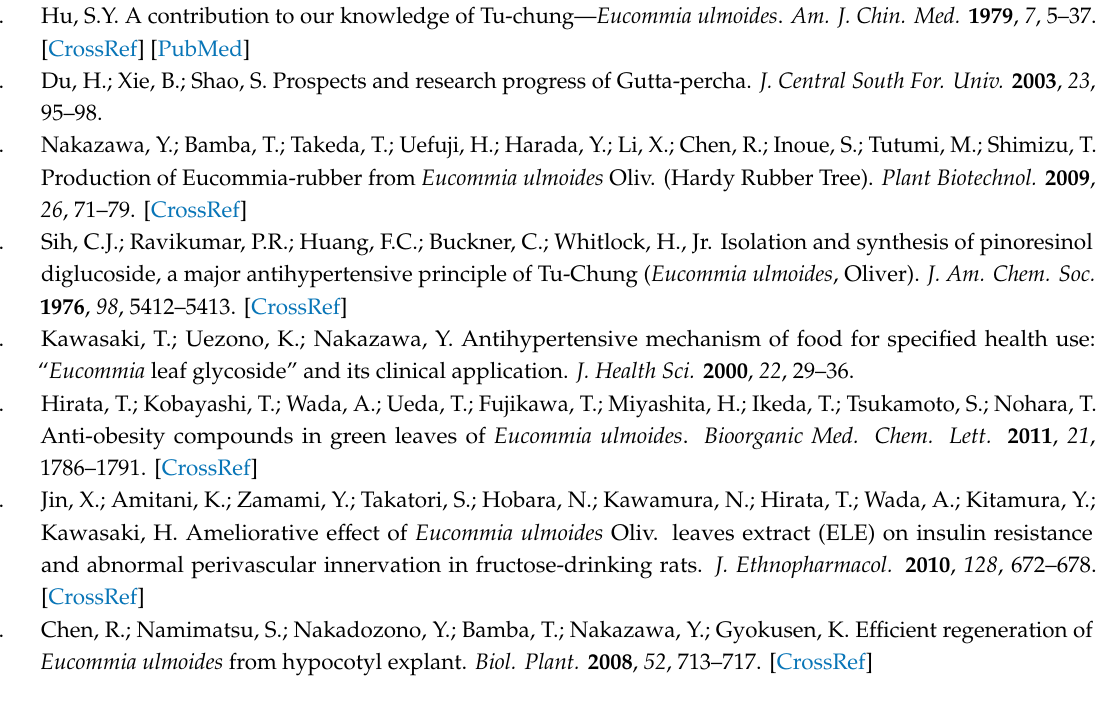
Table S1: Primer sequence of SSR markers, Table S2: Segregation of SSR locus, Table S3: The correlation coe ffi cient of growth trait in 10 consecutive years in Eucommia ulmoides F1 population (“Xiaoye” × “Qinzhong No.1”), Figure S1: The location of growth-related QTLs mapped on 19 linkage groups of Eucommia ulmoides . Author Contributions: Conceptualization, C.J. and Z.L.; Data curation, C.J.; Formal analysis, C.J.;